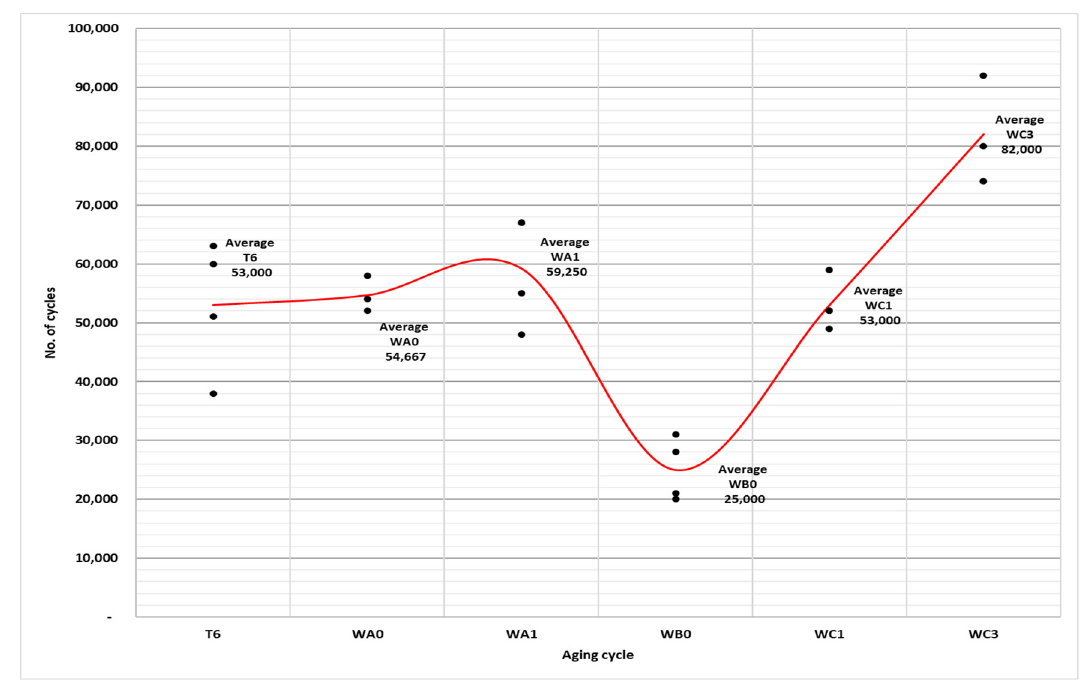
Figure 5. Results of cantilever bending fatigue test for standard samples.